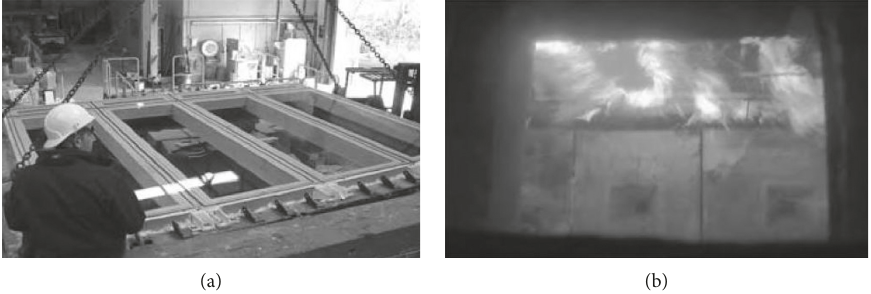
Figure 13: Fire tests on glazing floor, as reported in [75]. (a) Setup overview and (b) detail of the ongoing fire